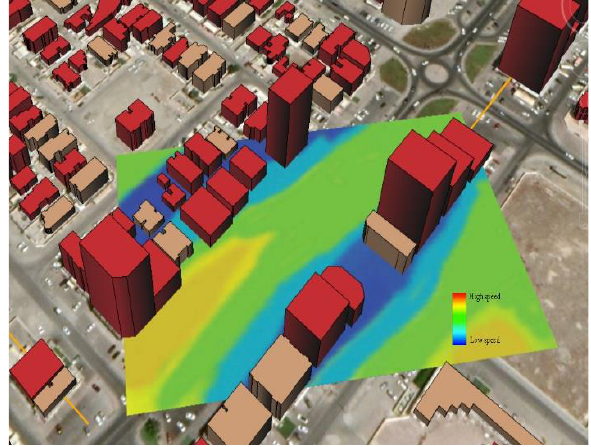
Figure 9: Airflow simulation in Al-Khoud.